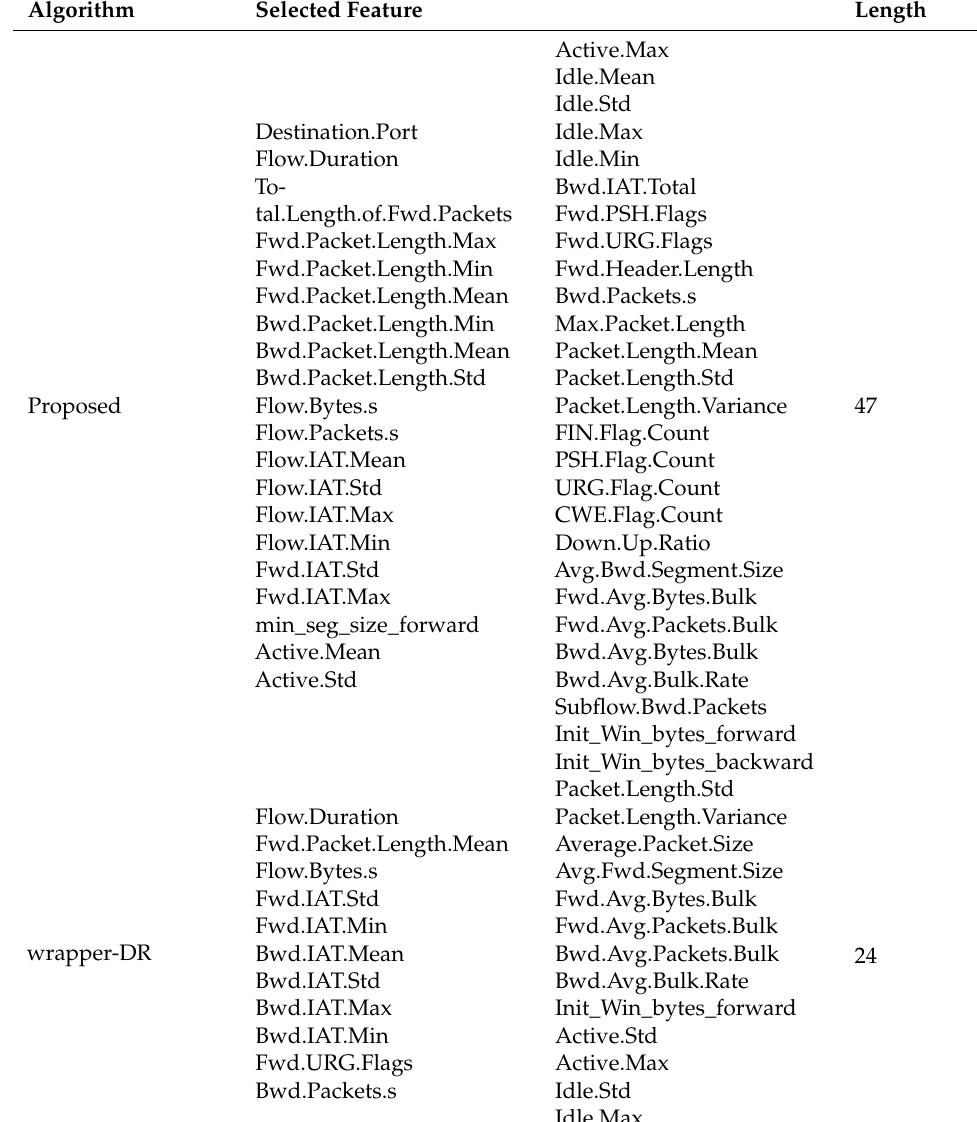
Table 9. Result of selected features by feature selection